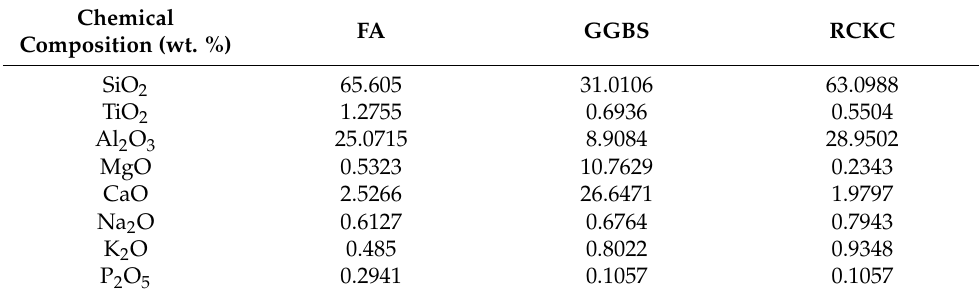
Table 1. Chemical composition of aluminosilicates. Chemical FA GGBS RCKC Composition (wt. %) SiO